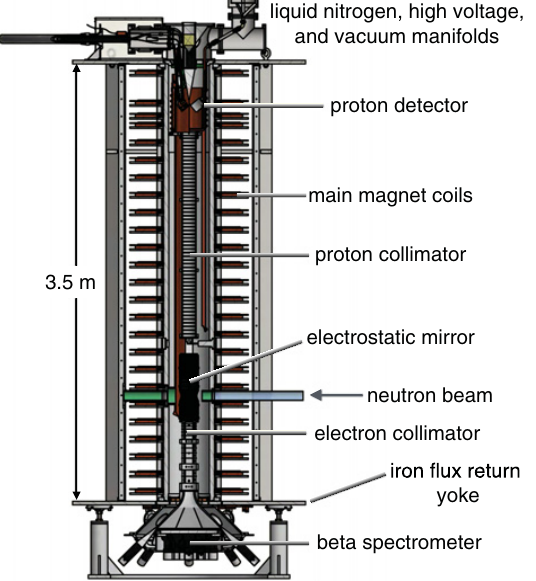
Figure 2. A diagram of the aCORN apparatus showing the major components and